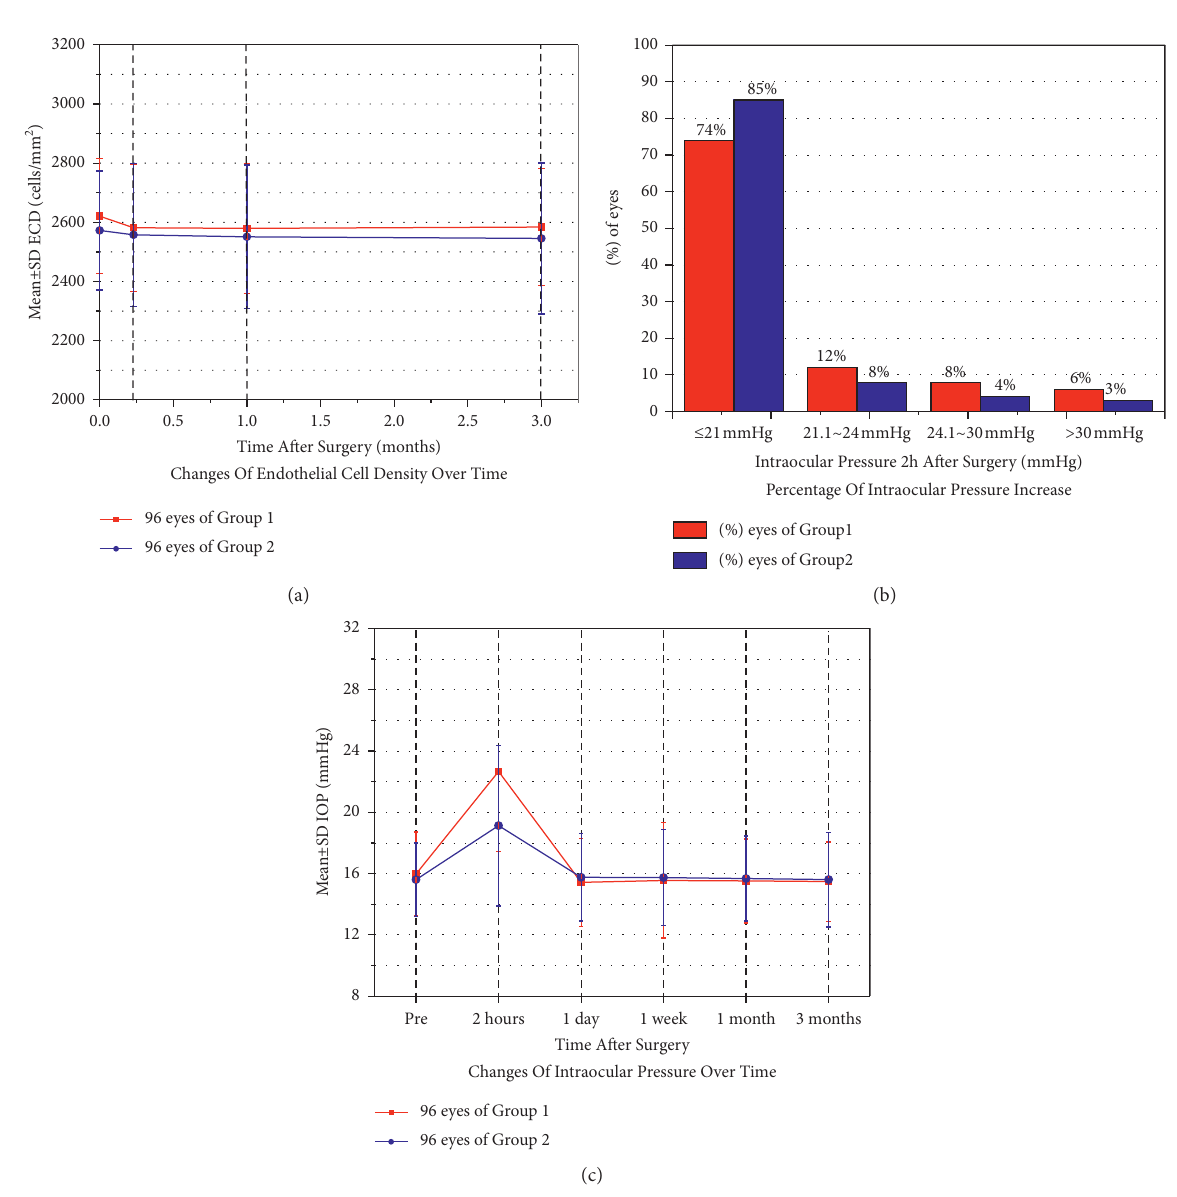
Figure 2: (a) Changes in corneal endothelial cell count over time. (b) Percentage of intraocular pressure increase at 2 hours following surgery. (c) Changes in intraocular pressure over time. SD, standard deviation; ECD, endothelial cell density; IOP, intraocular pressure. Table 3: Comparison of the intraocular pressure (IOP) (mmHg) between the two